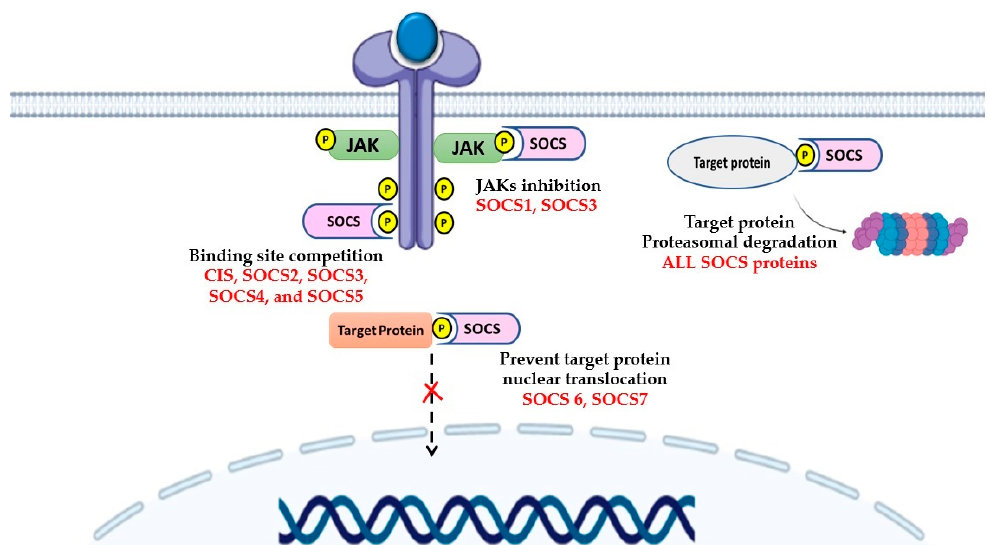
Figure 3. Mechanism of action of SOCS proteins. SOCSs negatively regulates intracellular signaling by several mechanisms: tagging the receptor or target protein for proteasomal degradation, blocking JAKs activity by acting as a pseudosubstrate, binding competition for the receptor phosphotyrosine that prevents the binding of other signaling molecules, and blocking nuclear translocation of signaling molecules.